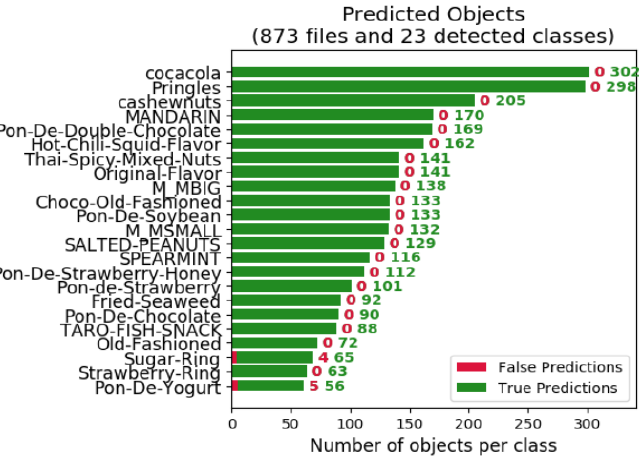
Figure 12. The top ‐ 1 error rate of only 2 object classes in 23 falls below 90%. Figure 12. The top-1 error rate of only 2 object classes in 23 falls below